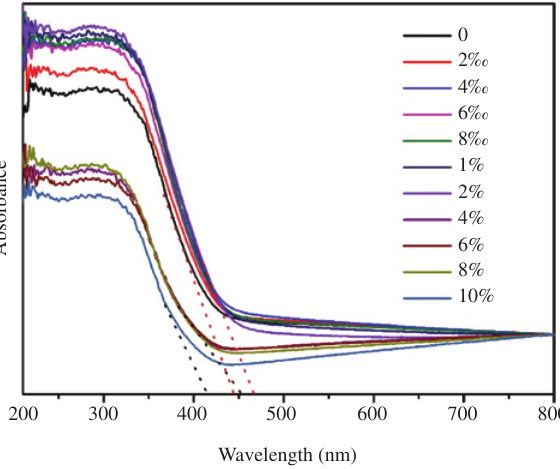
Figure 8: UV-vis diffusive reflectance spectra of the as-synthesized BWO and rGO-BWO